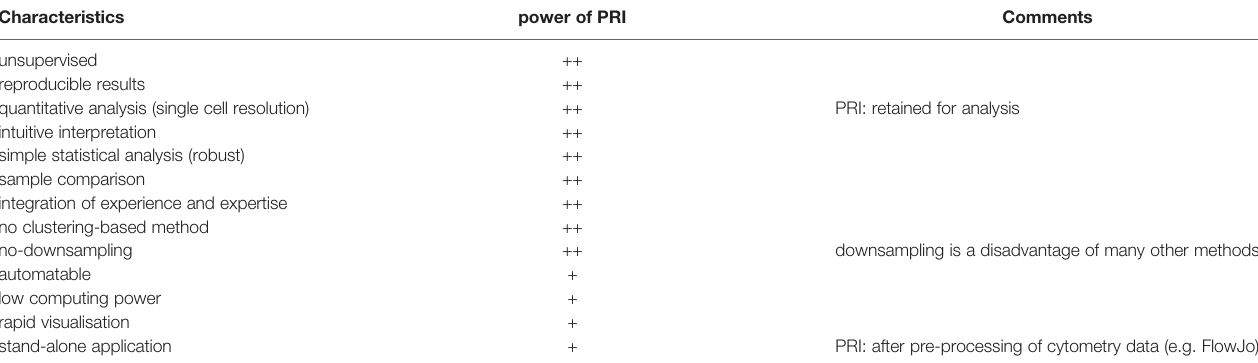
TABLE 1 | I Advantages of PRI.